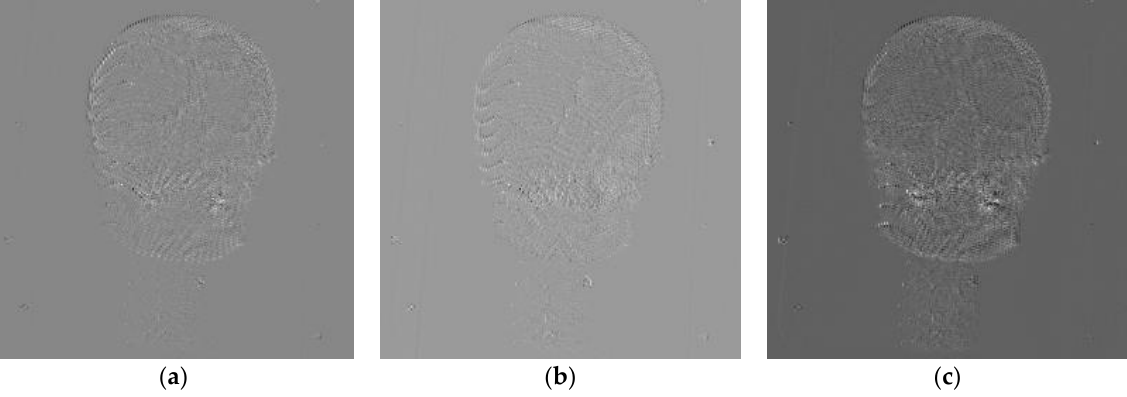
Figure 10. Multiresolution registration difference image. ( a ) Based on NCCS registration difference image; ( b ) based on NCCL registration difference image; ( c ) based on NCC registration difference image. Table 4. Data table of multiresolution experiment